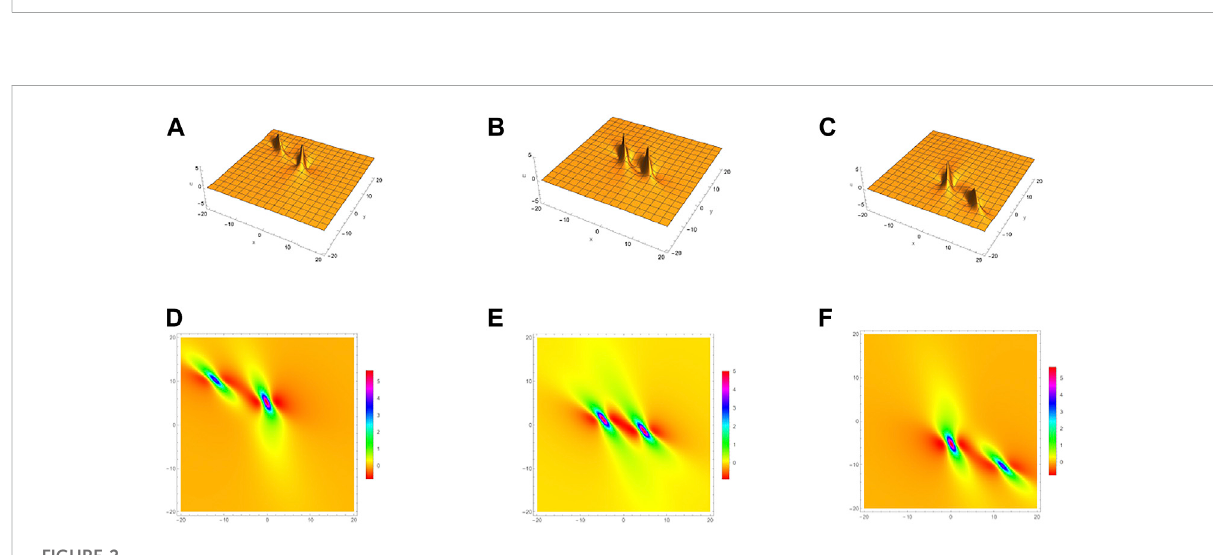
, b 1 = 1, b 2 (cid:2) 1 3